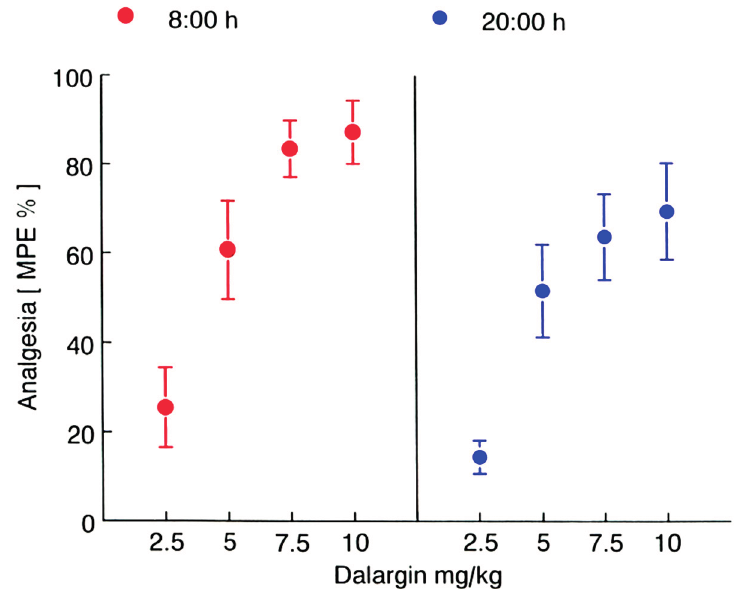
Figure 2. Dose-response effects of dalargin-coated nanoparticles. Response determined 15 min after intravenous injection (DAL/NP, 2.5–10 mg/kg) at either 08:00 or 20:00; lights on from 07:00 to 19:00. Shown are mean values ± SEM of the maximal possible effect (% MPE. Adapted with permission from [13]. Copyright 1999 Informa